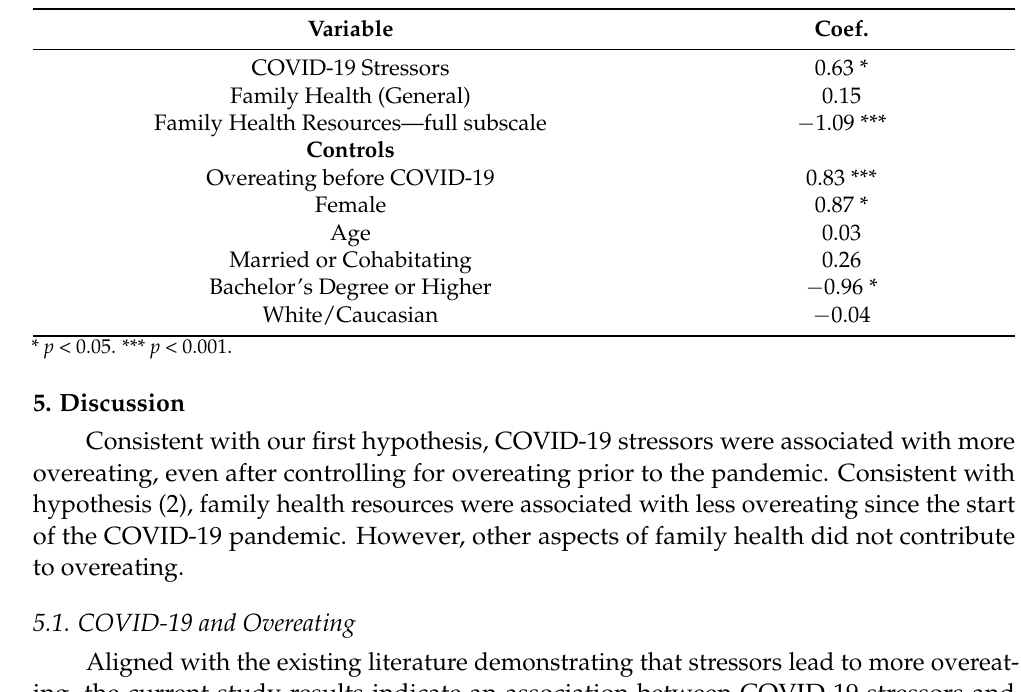
Table 2. Multiple linear regression of the effects of COVID-19 stressors and family health on overeat- ing during the COVID-19 pandemic, N =